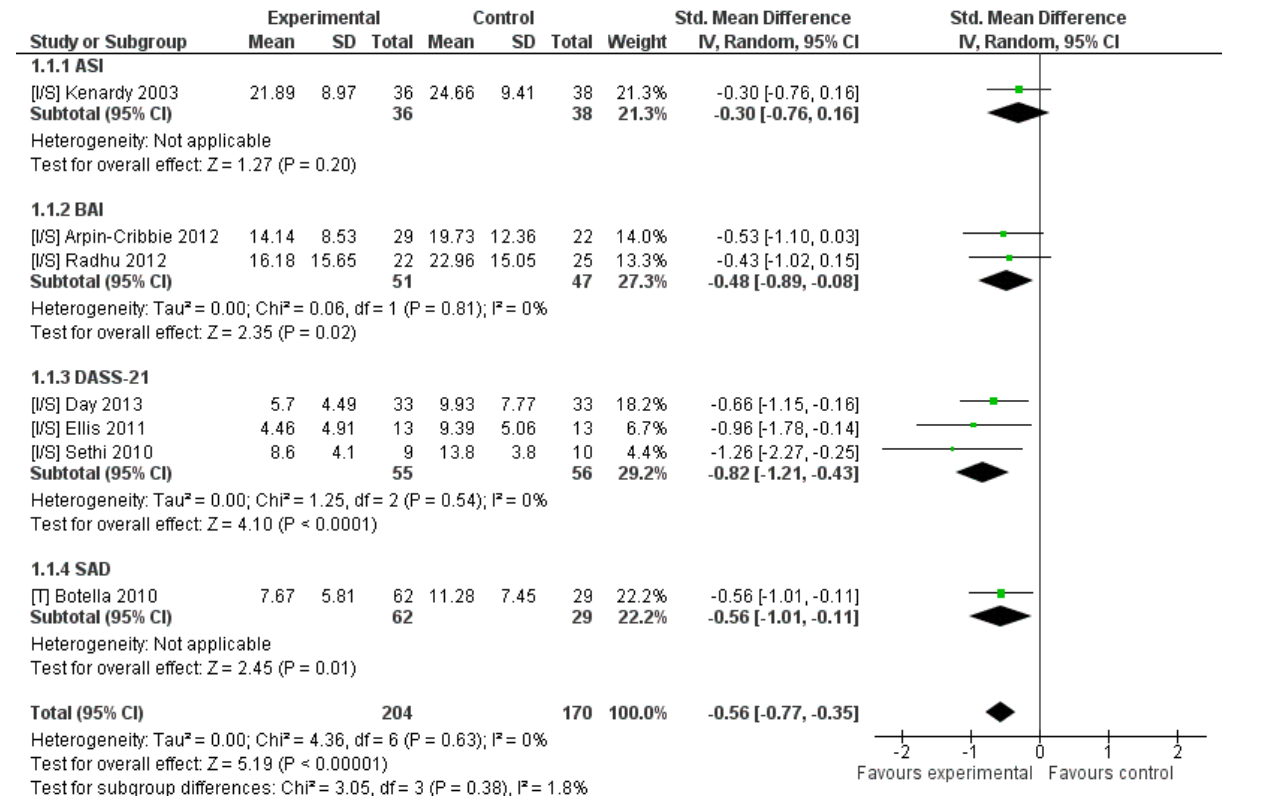
Figure 3. Sensitivity analysis of post-intervention anxiety outcomes for intervention compared to inactive controls.